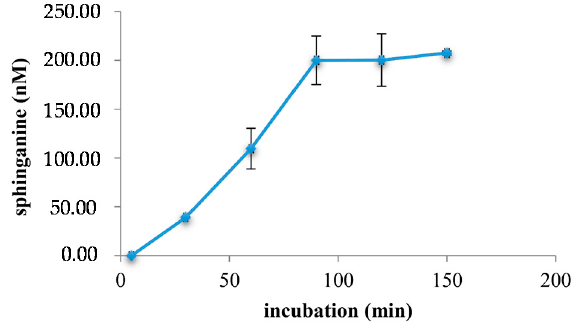
Figure 5. Human serine palmitoyl transferase (SPT) initial velocity evaluation.